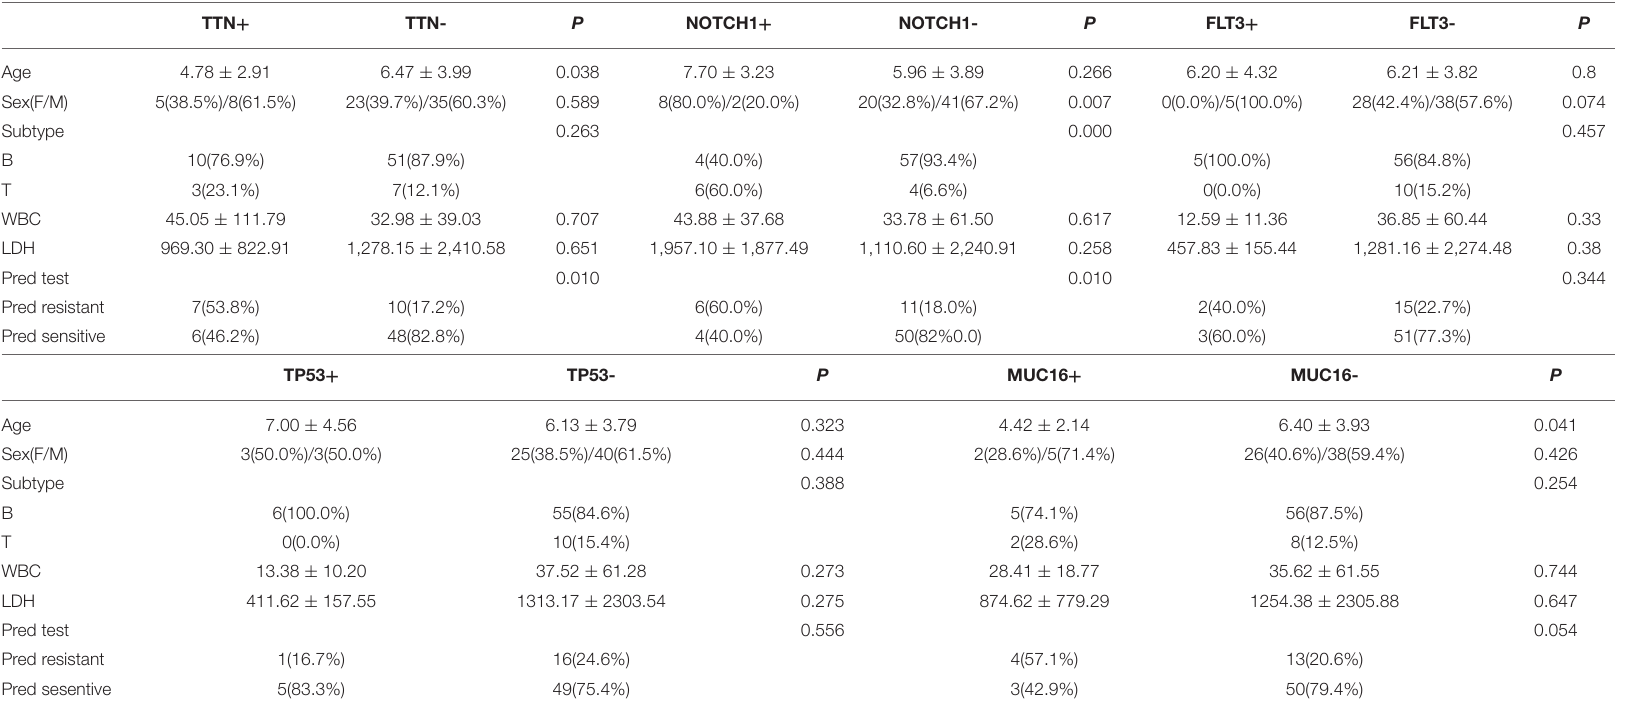
TABLE 4 | Clinical features associated with key gene mutations in pediatric acute lymphoblastic